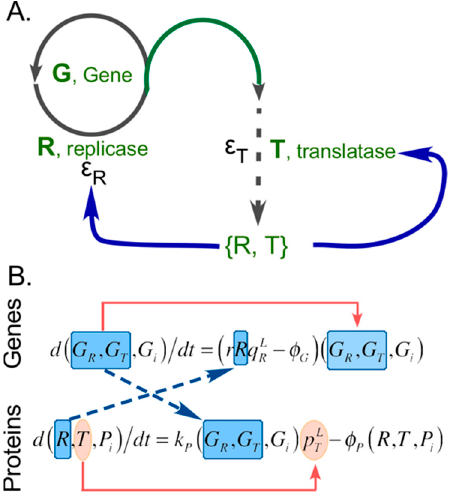
Figure 2. Coupling of replication to translation illustrated by the Gene-Replicase-Translatase model system. ( A ) The rudiments of the GRT system are the replicase and translatase catalysts and their genes (green). The three processes necessary to generate the active catalysts, R and T are replication (circle), translation (dashed line), and folding (blue lines). No distinction is made between duplication and transcription of the respective genes, G , in a world where genetic information is instantiated in RNA. Errors are denoted by ε . ( B ) Differential equations for the two processes [5] are coupled in both directions via the population variables (dashed arrows) and exhibit autocatalysis (red arrows).